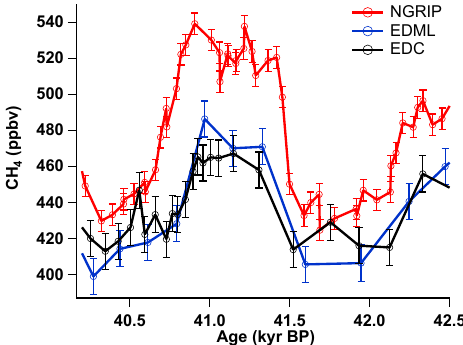
Figure 6. Synchronization of the methane profile from NGRIP with EDC and EDML profiles. The methane data are from Baumgartner et al. (2014) for NGRIP, Loulergue et al. (2007) for EDC and Schilt et al. (2010) for